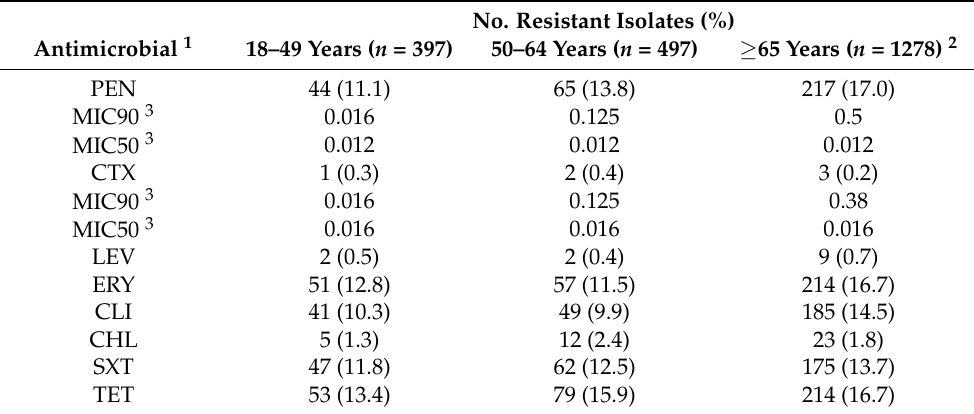
Table 4. Number of isolates responsible for invasive pneumococcal disease in adult patients, accord- ing to vaccine serotype groups and age groups, from 2015 to